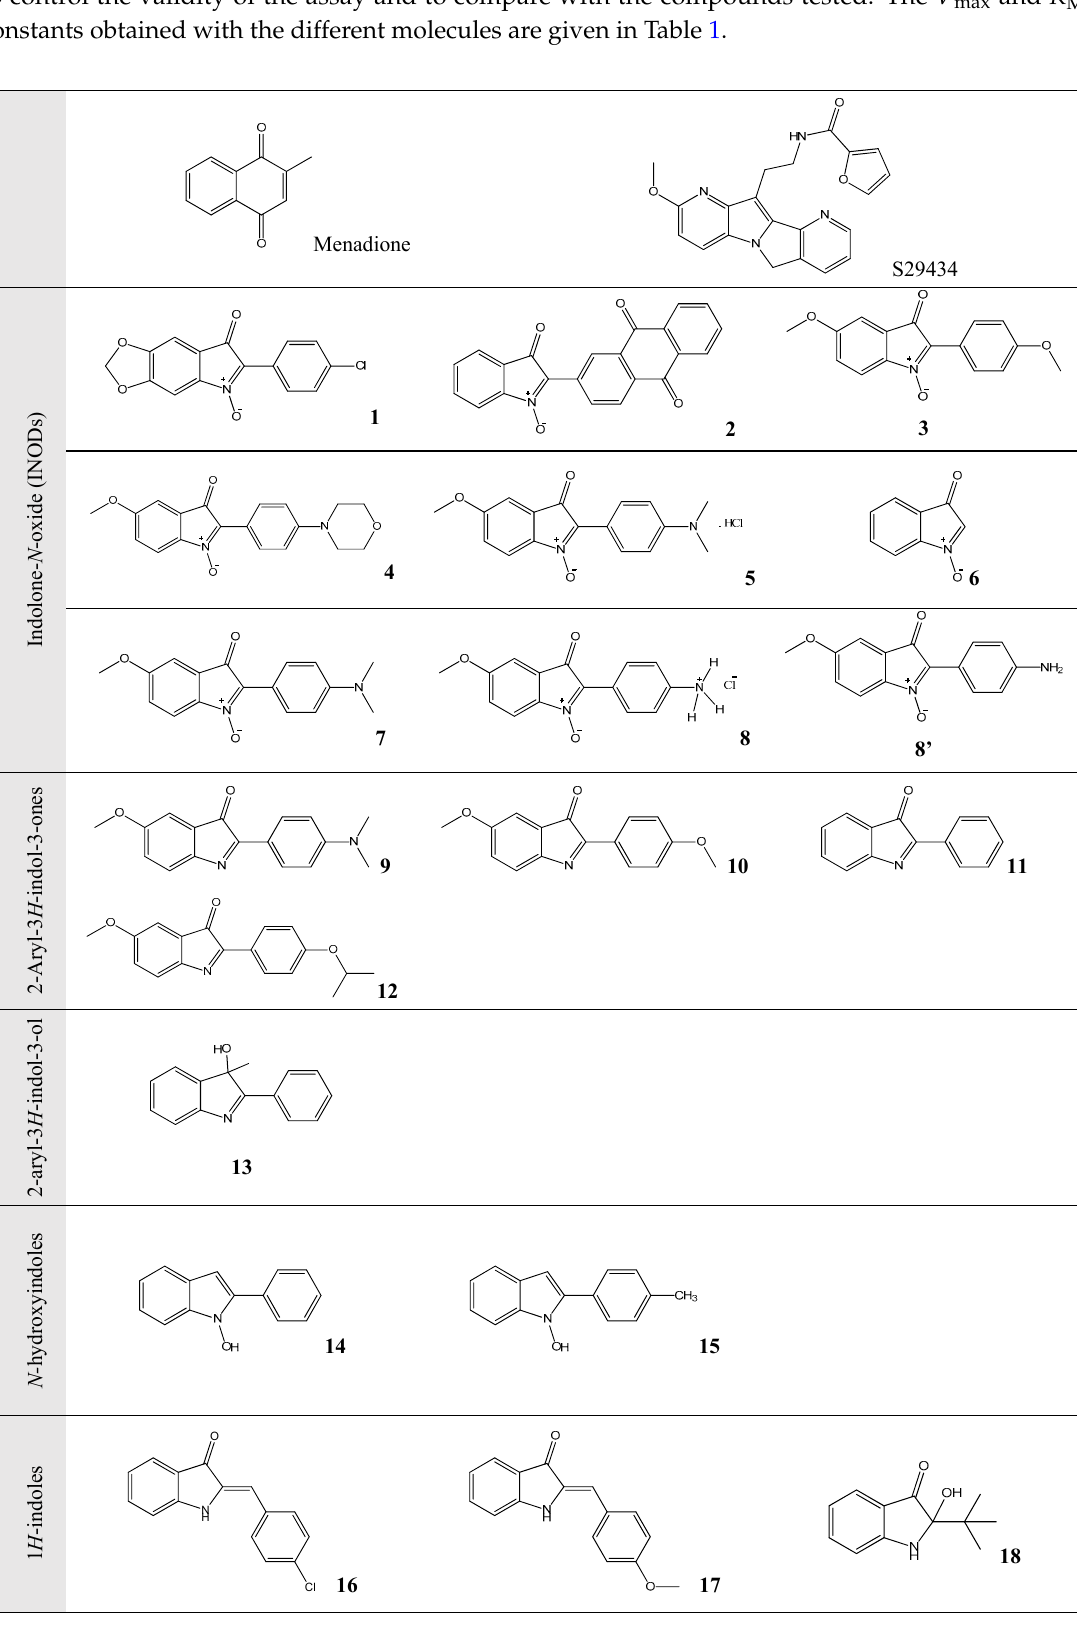
Figure 1. Structures of the compounds tested in this study.